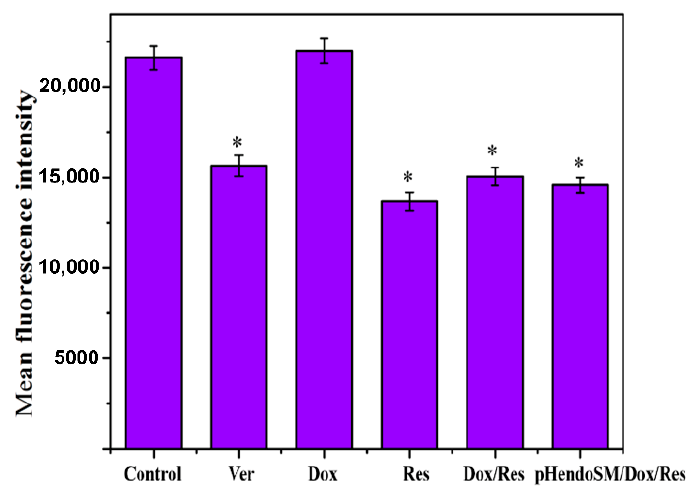
Figure 5. P-glycoprotein(P-gp) expression following treatment with Dox, Res, Dox / Res and pH-endoSM / Dox / Res micelles for 6 h in MCF-7 / ADR cells. FITC-P-gp was performed and green fluorescence was detected by flow cytometry. Data were expressed as mean ± SD ( n = 3), * p < 0.05, compared with the control